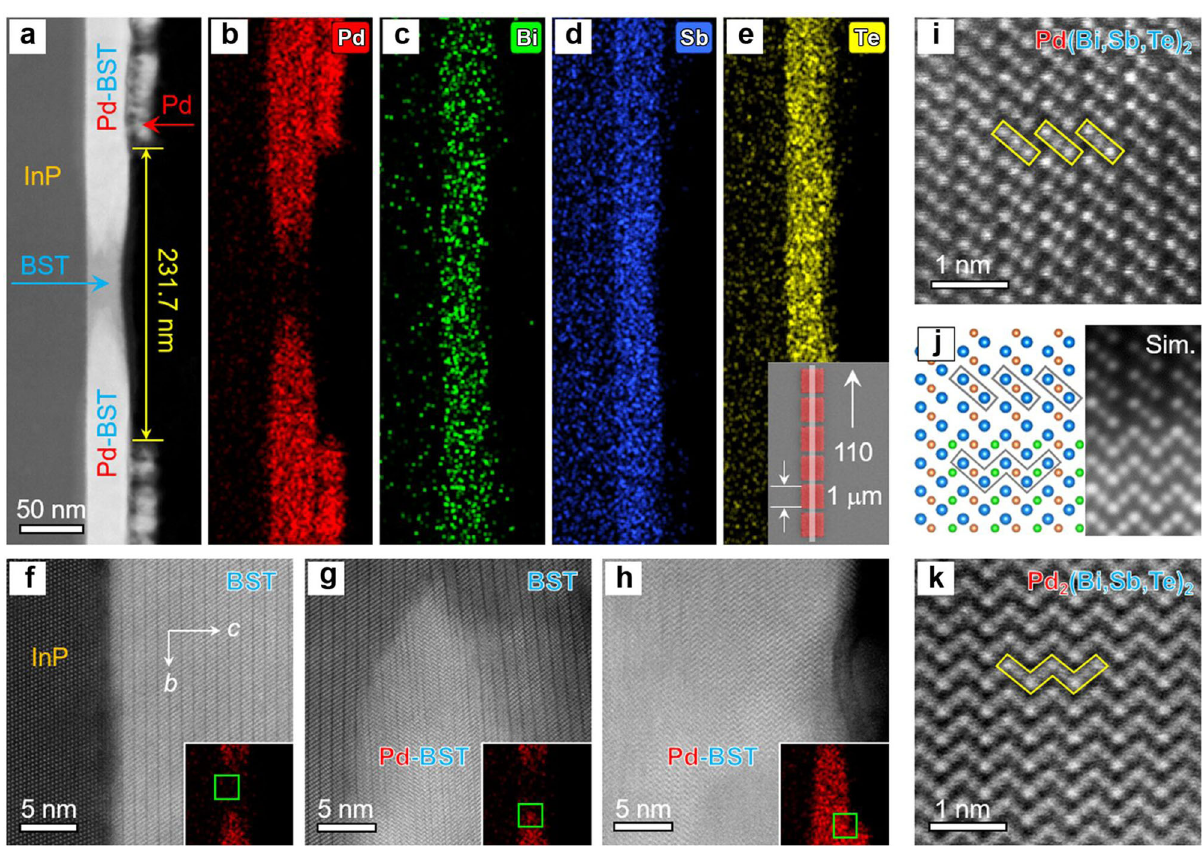
Fig. 1 Cross-section of a BST nanowire sandwiched by Pd-BST. a – e HAADF-STEM image and corresponding EDX spectroscopy maps of Pd, Bi, Sb and Te, respectively, of a cross-section of the Pd-BST/BST/Pd-BST heterojunction on InP substrate. The inset in panel e shows a plan-view SEM image of the Pd- pad array; the light-gray stripe depicts how the lamella specimen shown in panel a was cut out. f – h Atomic-resolution morphology of three locations in the specimen marked with green squares in the insets; the lattice image indicates the electron-beam incident direction of 〈 100 〉 or 〈 110 〉 . i – k High-resolution HAADF image of PdTe 2 -like ( i ) and PdTe-like ( k ) structure of Pd-BST, together with schematic structural model and simulated HAADF image (thickness~ 39 nm) to consider additional Pd atoms (green) intercalated into the PdTe 2 -like structure ( j ). In panel j , the atomic sites colored in blue, orange, and green may be occupied by Te/Bi/Sb, Pd/Sb, and Pd, respectively. Since the contrast of HAADF image is approximately proportional 38 to square of the atomic number, Z 2 , one can see from the atomic contrast in panel i that Bi atoms are found only on the Te sites of the PdTe 2